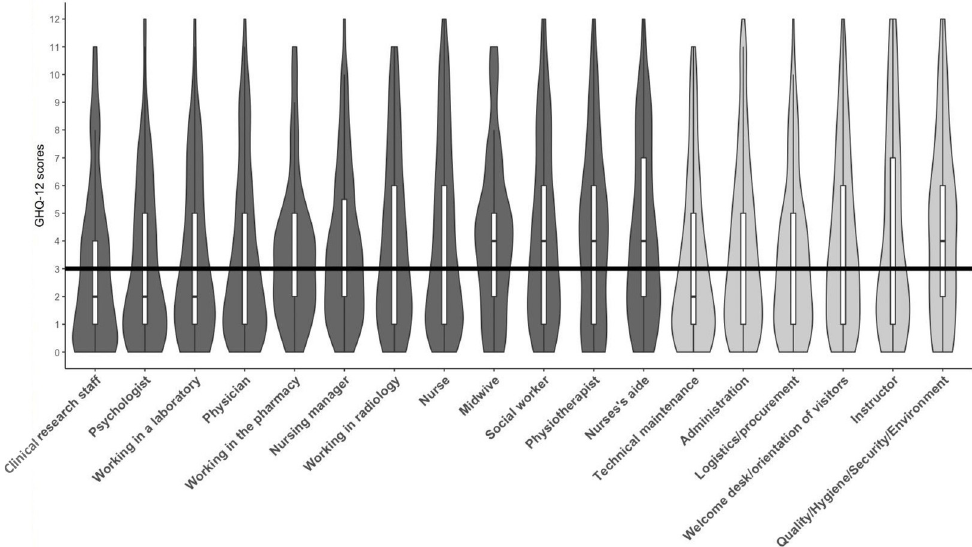
Fig 2. Histogram and quartiles of GHQ-12 scores by profession. The black line represents the threshold of GHQ-12 scores signifying the likely presence of psychological distress. Professions considered as “medical/caregiving” are shown in dark grey, and “non-medical” professions in light